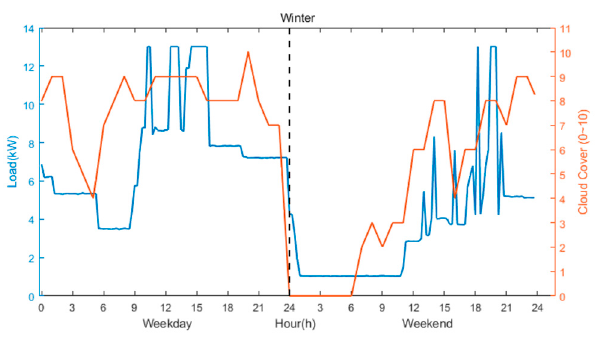
Figure 5. Energy consumption variations with cloud cover.